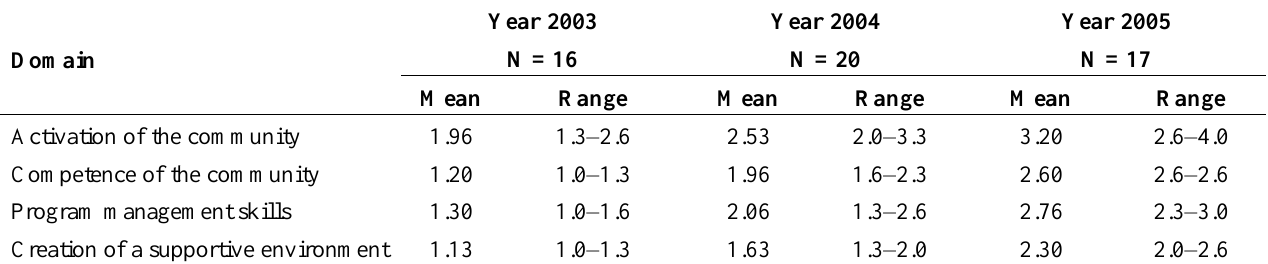
Table 6. Community empowerment domains assessed by the Safe Community program workgroup.